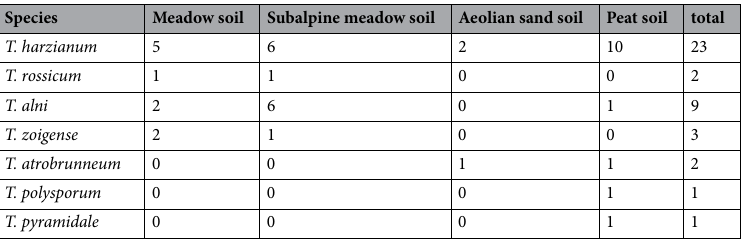
Table 3. Isolation frequency of Trichoderma species in different soil types (%).